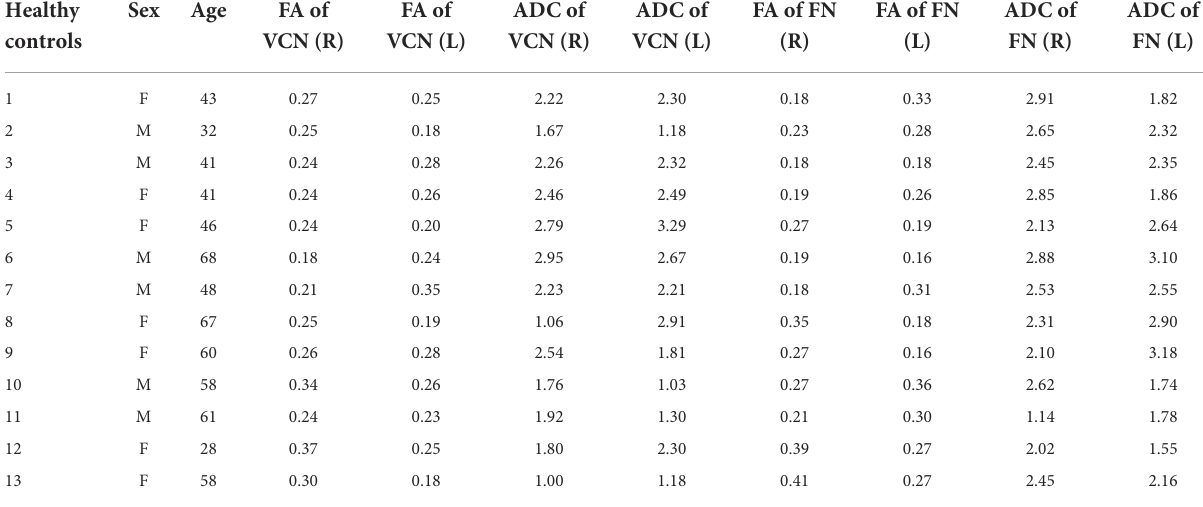
TABLE 2 Diffusion tensor imaging (DTI) parameters of healthy controls. Healthy